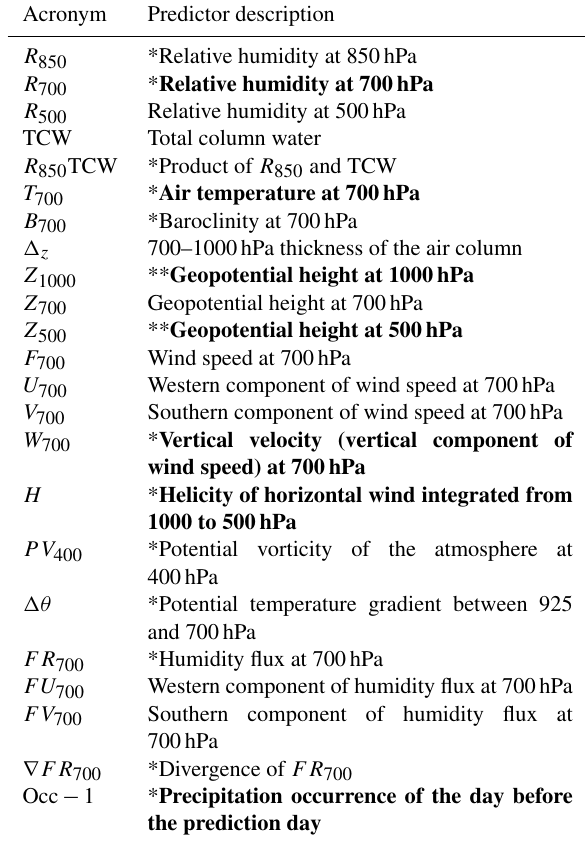
Table 1. Large-scale potential variables considered in the work. Stars: predictors obtained from the best GLMs identified for the 12 test SAFRAN grid cells (Sect. 2). Double stars: predictors used for the analog stage. Bold text: predictors retained for the SCAMP ver- sion presented and evaluated in this work. See Holton and Hakim (2012) for the definition of the